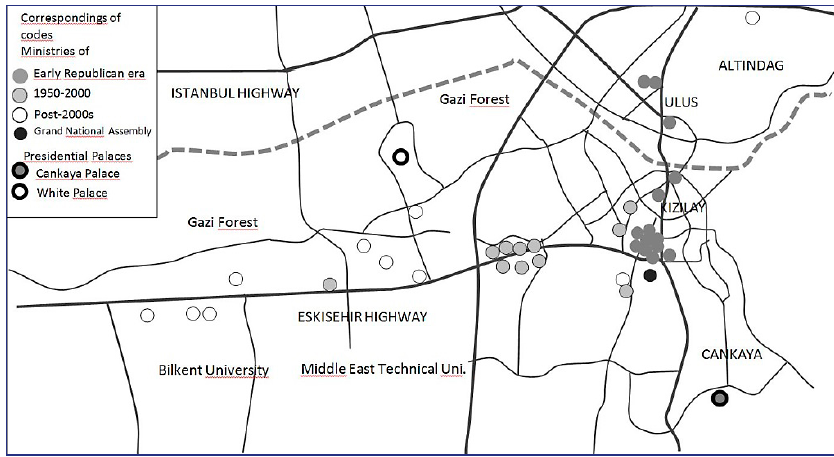
fig. 3. Present locations of ministries and presidential palaces in ankara according to their construction